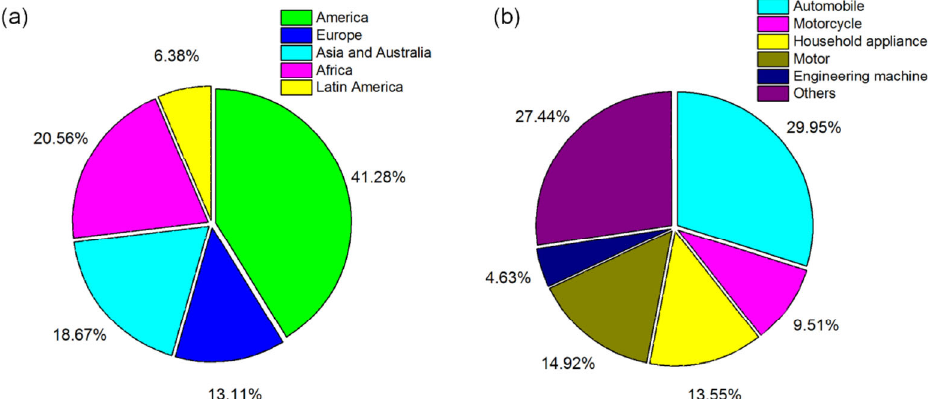
Fig. 10 (a) Market proportion of main bearing-demanding regions in the world and (b) proportion of bearings sold to different